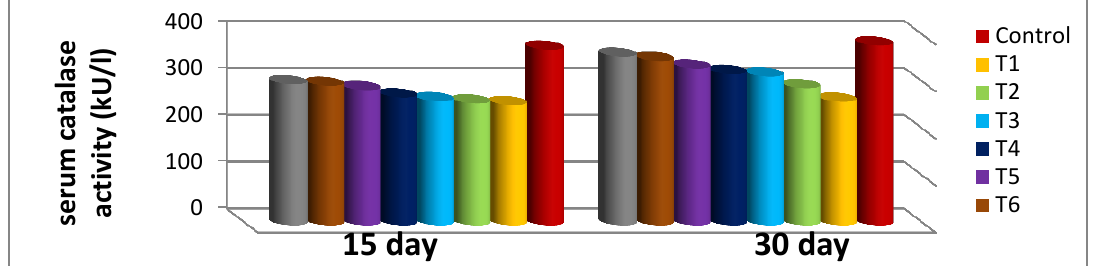
Figure 4: Effect of different doses of total polyphenol extracted from green tea for 15 and 30 days on serum catalase activity (kU/l) of iron overload treated rats.